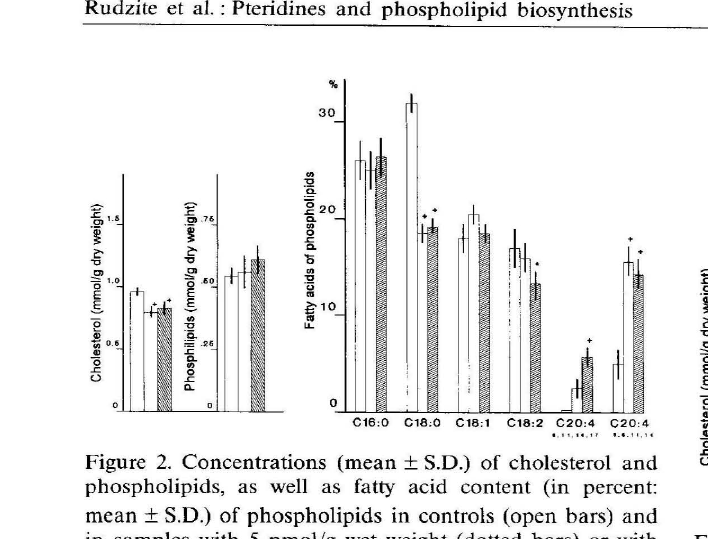
Figure 4. Concentration (mean ± S.D.) of cholesterol and phospholipids, as well as fatty acid content (in percent: mean ± S.D.) of phospholipids in controls (open bars) and in samples with 5 pmol/g wet weight (dotted bars) or with 30 pmol/g wet weight (hatched bars) xanthopterin. Samples of rat liver tissue homogenate were used to test for phospholipid biosynthesis in vitro. In cubation medium: Krebs-Ringer-phosphate buffer (pH=7. 4), fatty acid mixture and glycerol. Samples were incubated twice for 4 h at